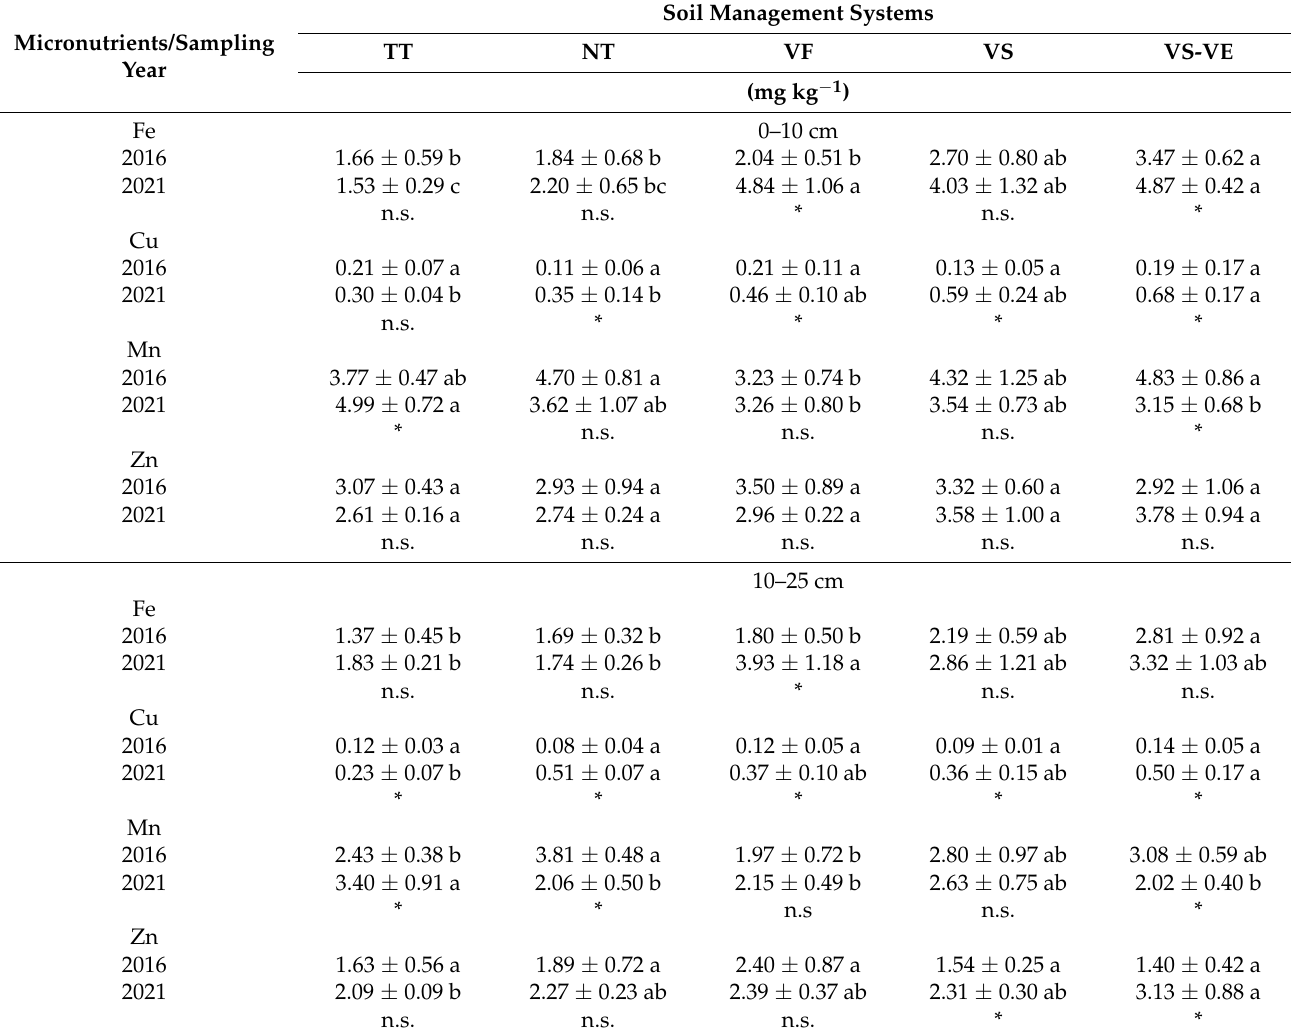
Table 3. Average soil micronutrient contents by effect of different soil management strategies during the study